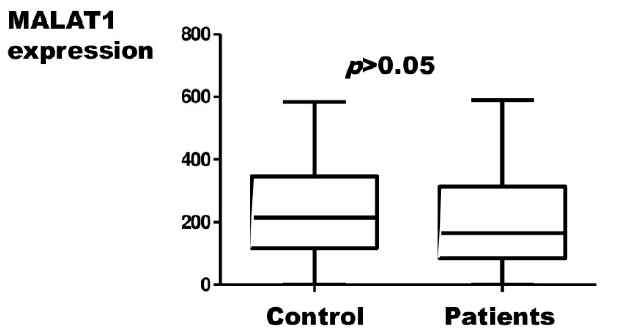
Figure 3. Relative expression of the MALAT1 in endometriosis patients with respect to the control material (Mann–Whitney test; p > 0.05).